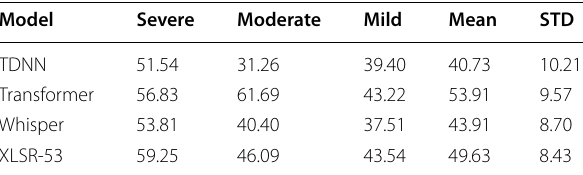
Table 4 (Means and STD of) WER in % of the each impairment severity